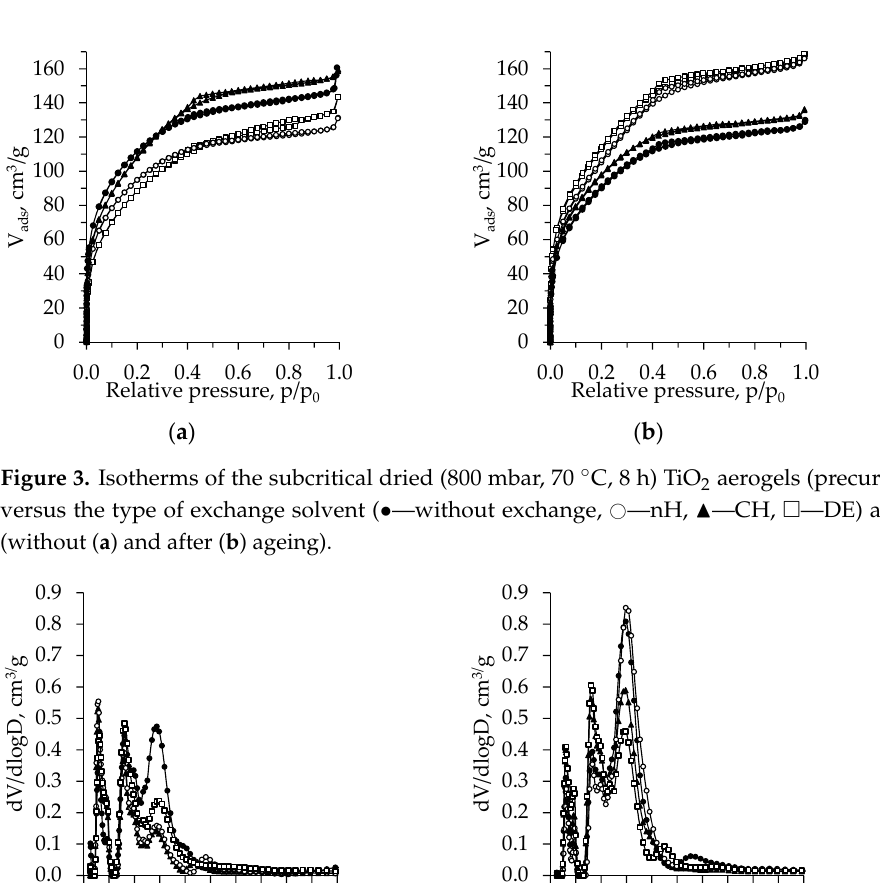
Figure 4. The pore size distribution of the subcritical dried (800 mbar, 70 °C, 8 h) TiO 2 aerogels (precursor TIP) vs. the type of exchange solvent ( ● —without exchange, ○ —nH, ▲ —cH, □ —DE) and ageing (without ( a ) and after ( b ) ageing).